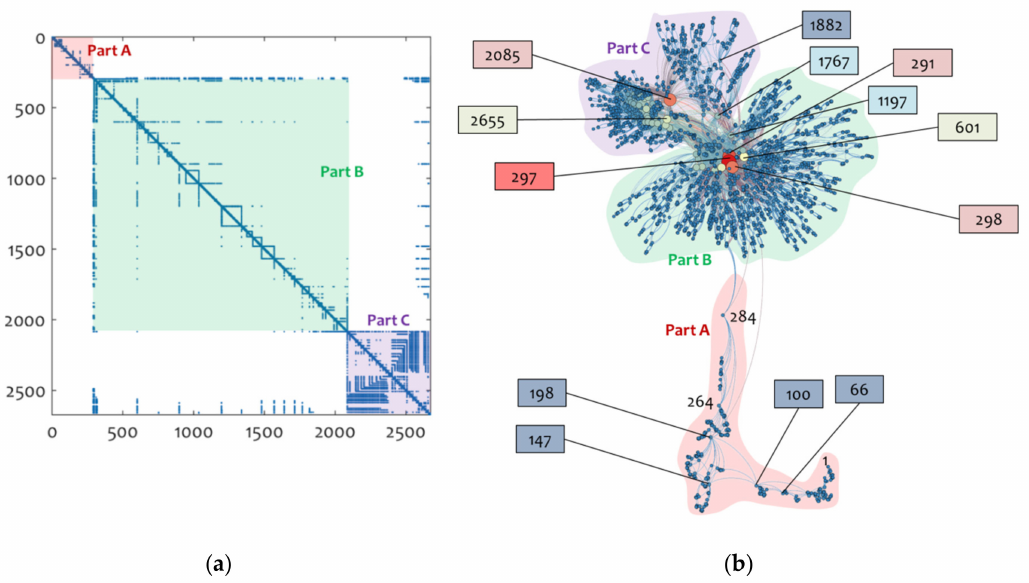
Figure 4. ( a ) Sparsity (spy) plot (see [38]) and ( b ) the Force-Atlas graph layout [44] of the visibility graph associated to the available voltage oscillation time-series of TlInTe 2 (see Figure